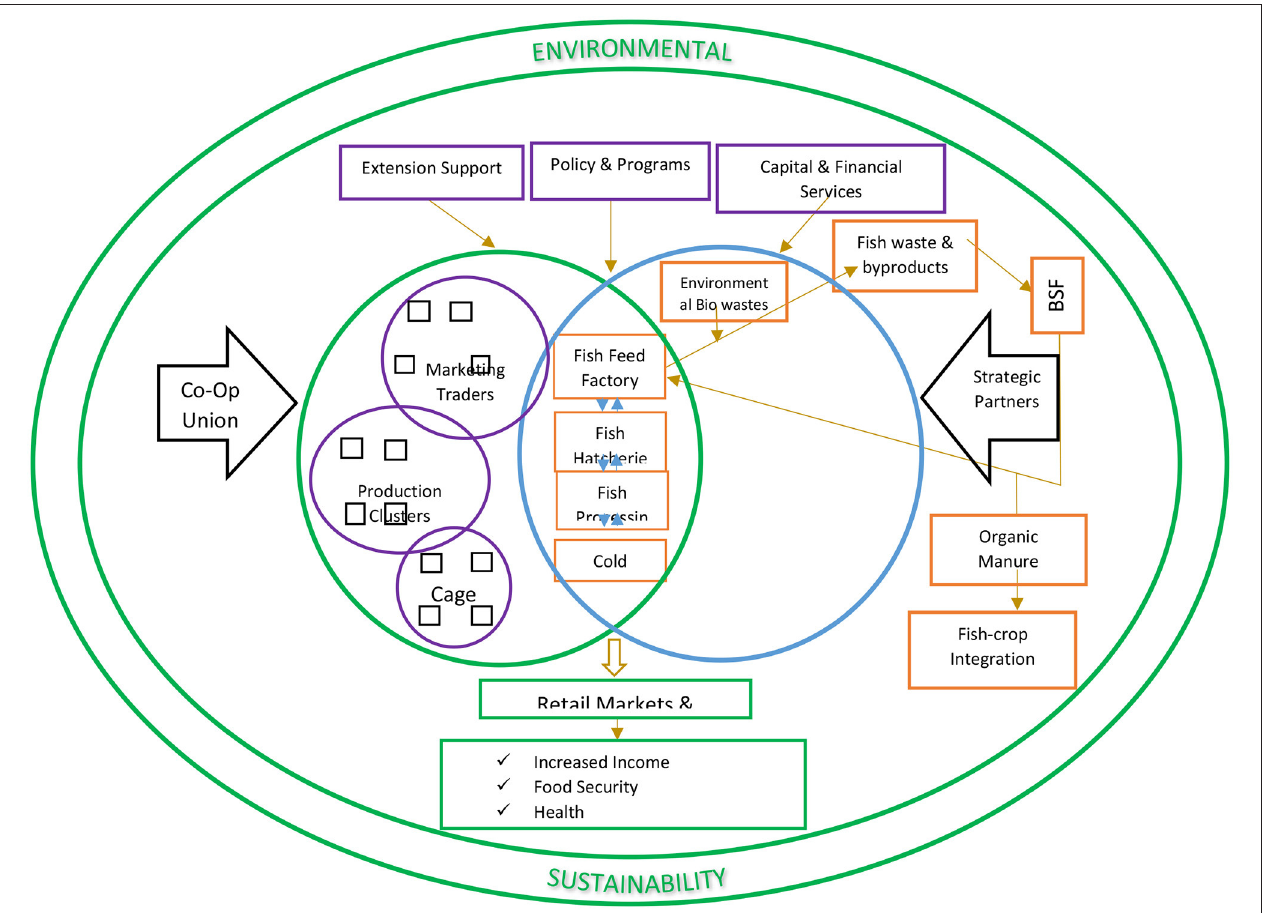
FIGURE 1 | Conceptual framework and schematic flow of an ideal aquapark unit showing all components of food production and value chain linkages; BSF, Black Soldier Fly.